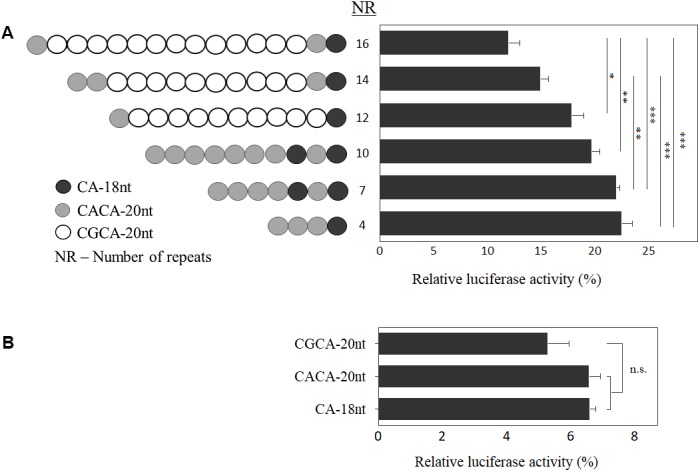
Functional analysis of EIF4A3 5′UTR motifs. Graph depicting the relative luciferase activity, in percentage, of the constructs carrying different number of motifs (A) and of each motif independently (B). Data are represented as mean ± SEM of five experiments, which were performed in triplicate. Relative luciferase activity = [(experimental sample ratio) – (negative control ratio)/(positive control ratio) – (negative control ratio)]. ∗∗∗p < 0.001, ∗∗p < 0.01, ∗p < 0.05 and ns, non-significant; one-way ANOVA with Tukey post hoc tests.